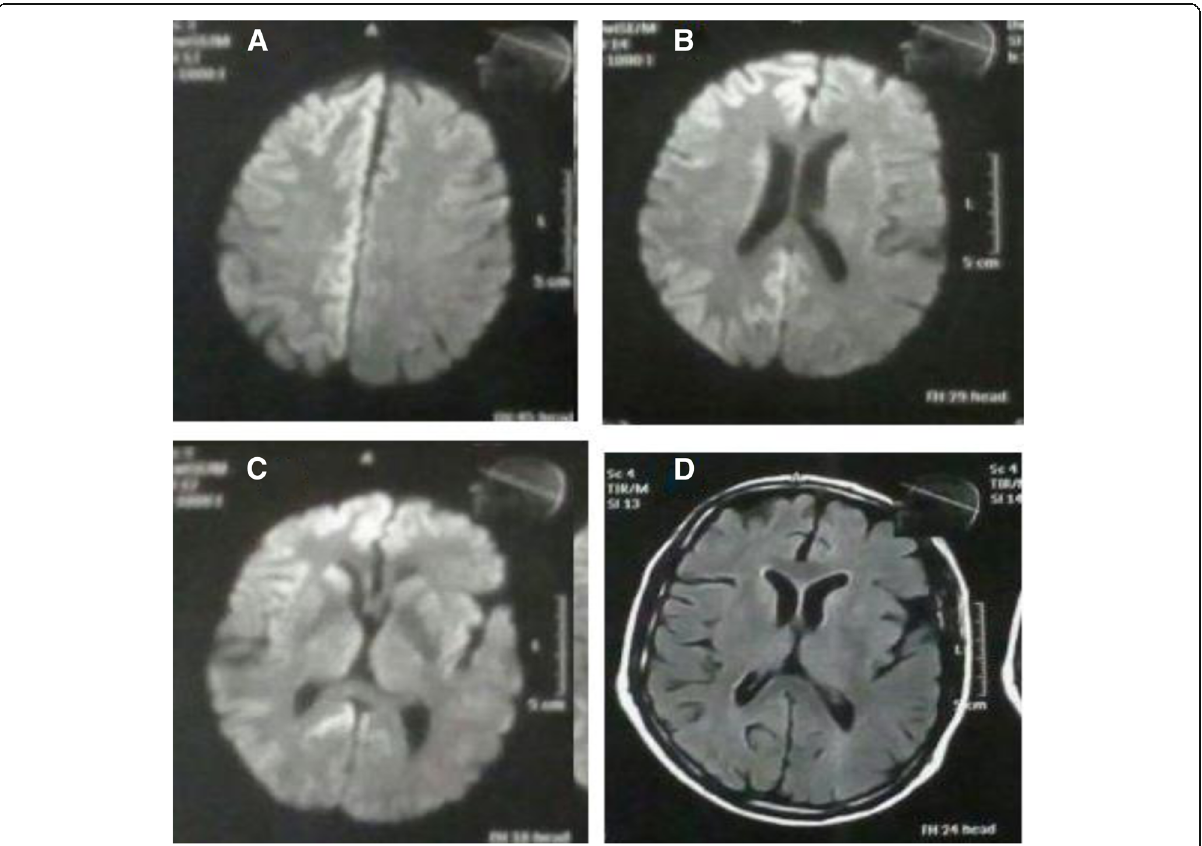
Fig. 2 Brain MRI in different sequences. MRI diffusion-weighted images showing hyperintense signal (more right) in the cingulate gyrus ( a ), frontal lobe ( b ), and caudate areas ( c ). T1W brain MRI with contrast image shows diffuse cortical enhancement ( d )